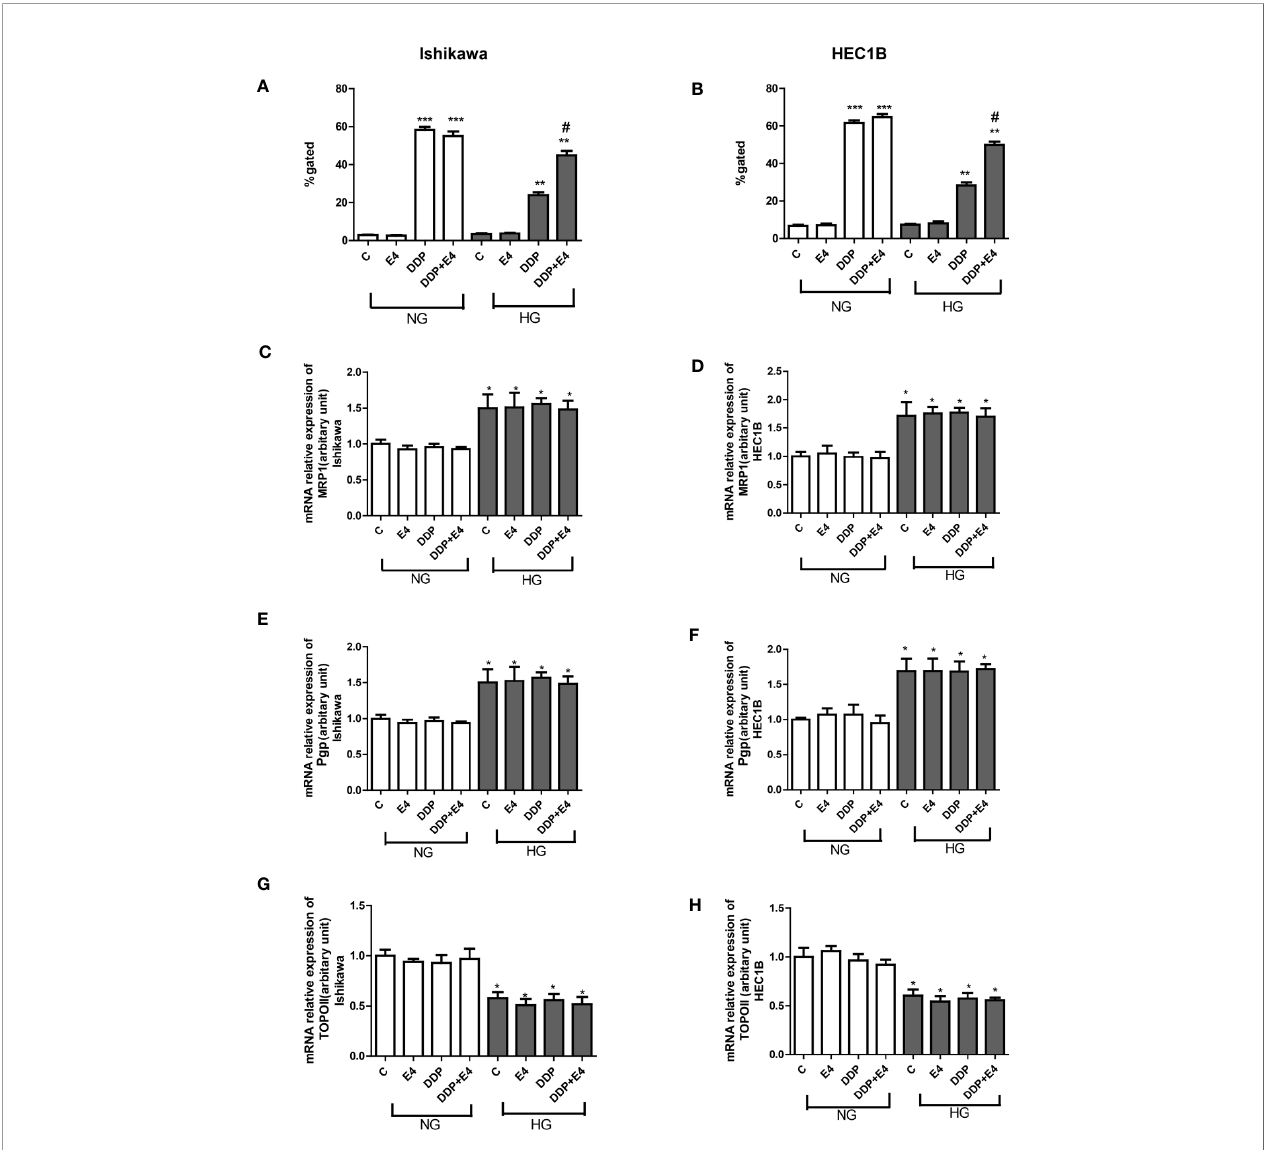
FIGURE 2 | Effects of Exe-4 on rhodamine 123 amounts and the expression levels of MRP1, Pgp, and TOPO II genes after treatment with DDP under NG and HG conditions. (A, B) Cells were cultured with rhodamine 123 to assess Pgp and MRP activity fl ow-cytometrically. Measurements were performed in triplicate. ∗∗∗ p < 0.001 DDP (25 µM), DDP (25 µM) + Exe-4 (10 nM) vs. control group and Exe-4 (10 nM) in Ishikawa (A) /HEC1B cells (B) cultured in NG; ∗∗ p < 0.01 DDP (25µM), DDP (25µM) + Exe-4 (10 nM) vs . control group and Exe-4 (10 nM) in Ishikawa/HEC1B cells cultured in HG; *p < 0.05 DDP (25 µM) + Exe-4 (10 nM) vs . DDP (25 µM) in Ishikawa/HEC1B cells cultured in HG. # p < 0.05 DDP (25 µM) + Exe-4 (10 nM) vs . DDP (25 µM) under HG conditions. At the same experimental conditions, cells were analyzed by quantitative real-time polymerase chain reaction (RT-qPCR) for MRP1, Pgp, and TOPO II genes in Ishikawa (C, E, G) respectively) and HEC1B (D, F, H) , respectively) cells. Measurements were performed in triplicate, and data are mean ± SEM; ∗ p < 0.05 Ishikawa and HEC1B cells cultured in HG vs . cultured in